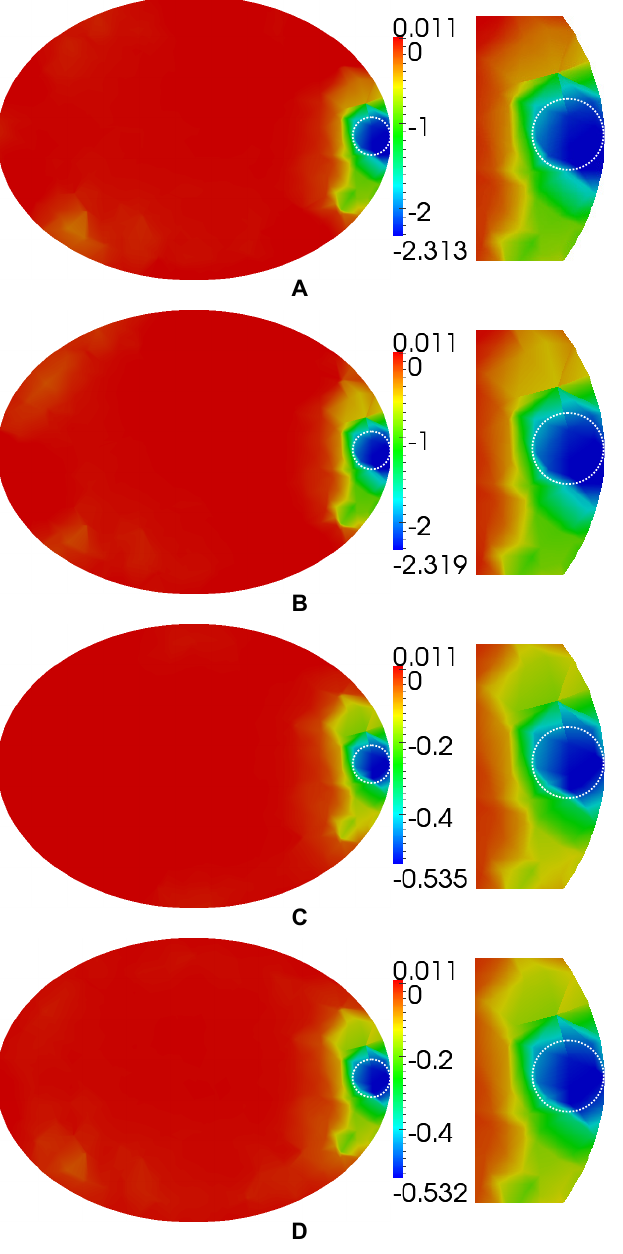
Fig. 9: Reconstructed images Im(Δ σ true ) of the non-rotated target medium in the reference measurements . The dotted white circle marks the position of the sphere which was identical to the initial position of the sphere before rotation in the error detection measurements